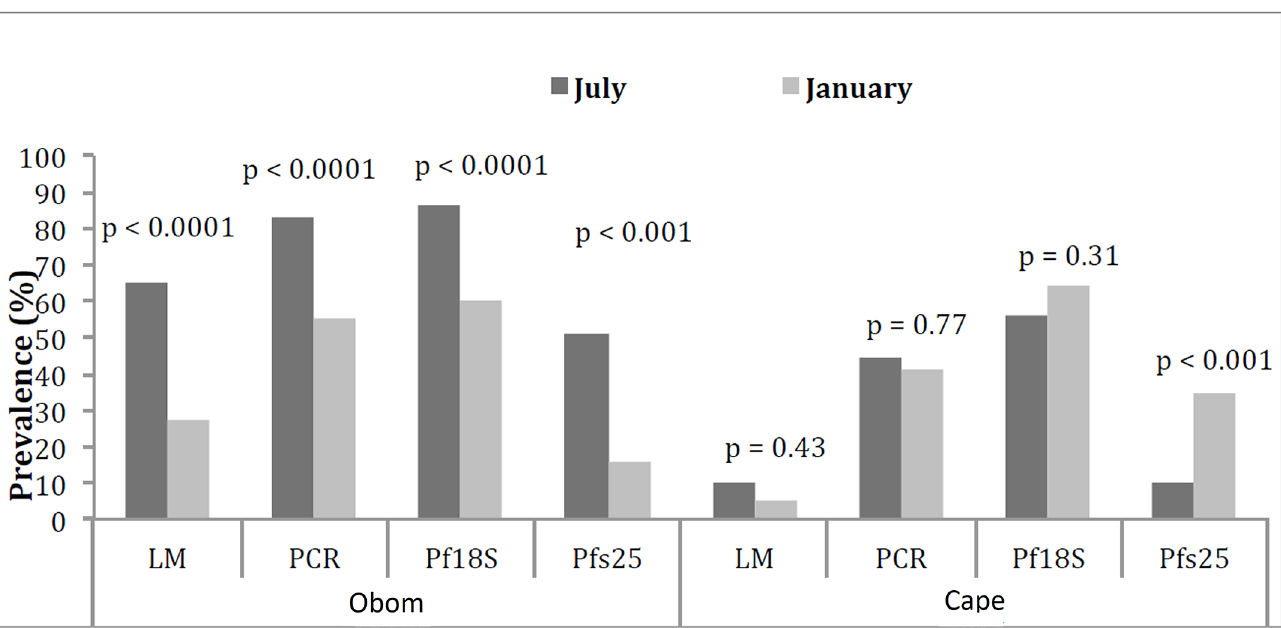
Fig 1. Asexual parasite and gametocyte prevalence in Obom and Cape Coast (Cape). Parasite prevalence in Obom and Cape Coast during the rainy and dry seasons as measured by microscopy (LM), conventional PCR ( Pf18S rRNA, DNA amplification) and by qRT-PCR ( Pf18S rRNA, transcript amplification) and submicroscopic parasite carriage determined using Pfs25